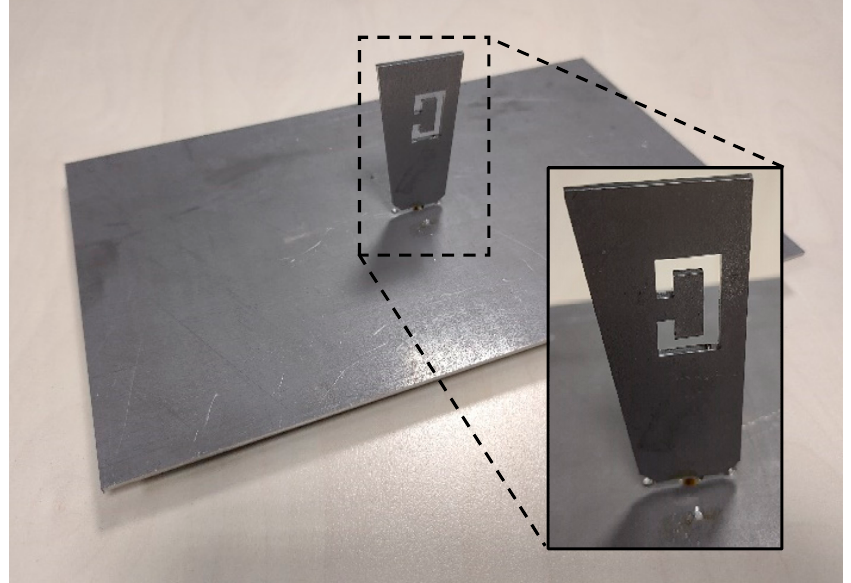
Figure 14. Manufactured blade antenna on a ground plane, including a pop-up box with detailed view of the ‘C’ shaped slot.